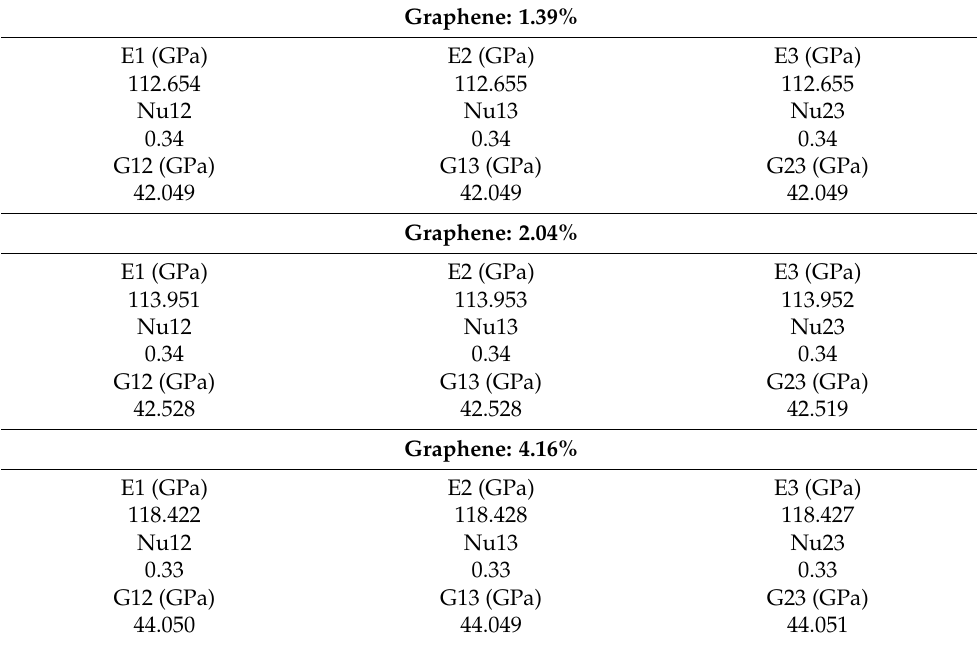
Table 3. The macroscale material properties of the RVE